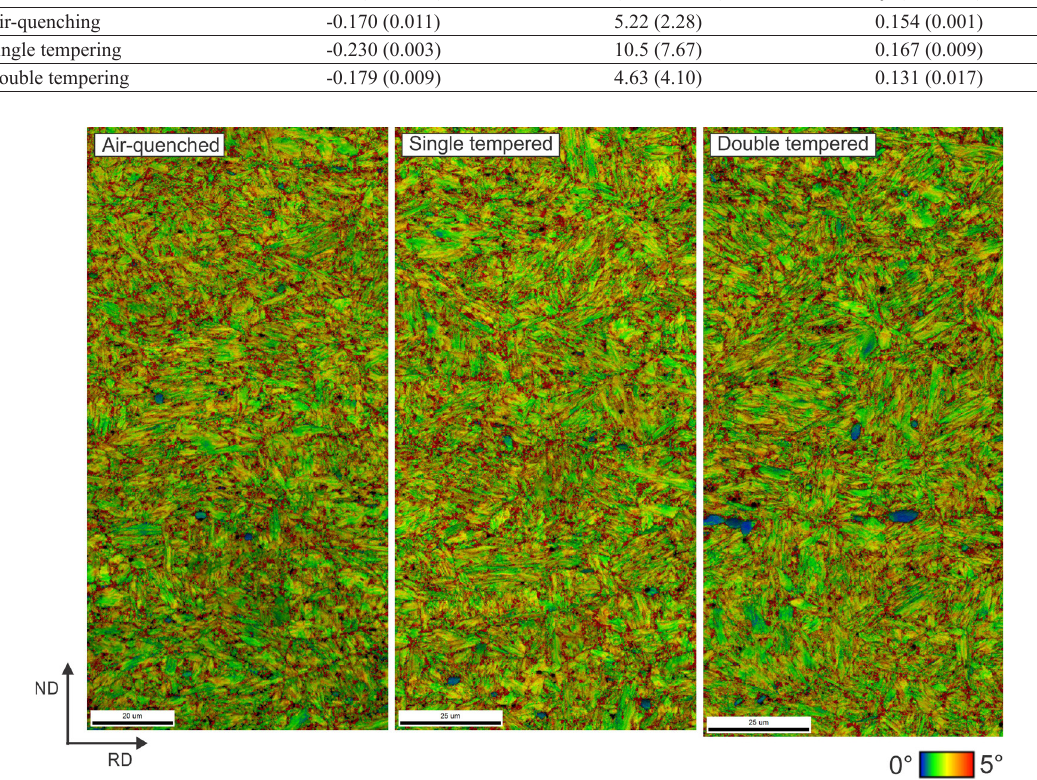
Figure 9. KAM maps of the samples after air-quenching, single tempering and double tempering treatments.